Question: Briefly state, in one sentence, what is plotted here.
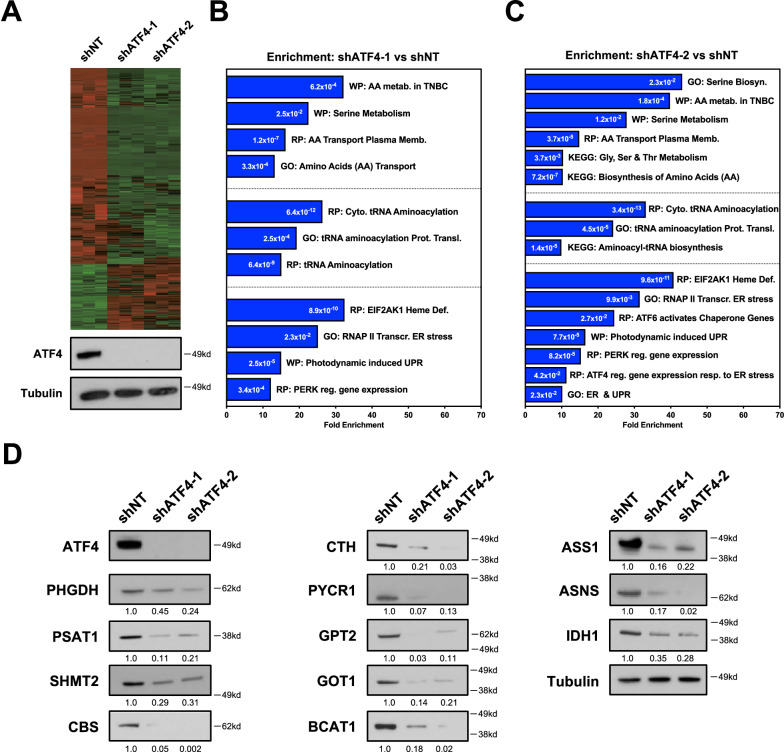
Answer: ATF4 regulates transcriptional programs associated with amino acid synthesis, import, and tRNA aminoacylation. A Top , Heatmap of differentially expressed genes between NT- and ATF4-shRNA-expressing NOMO-1 cells. Bottom , Western blot analysis of FACS-purified NOMO-1-RFP+ cells expressing DOX-inducible shNT, shATF4-1, or shATF4-2 was conducted for each replicate. RNA-seq data represent 3 replicates of the only biological replicate. B , C Pathway enrichment analysis comparing RNA-seq profiles of shNT vs shATF4-1 ( B ) or shNT vs shATF4-2 ( C ). The analysis was performed using GO_BP (GO), KEGG, Reactome (RP), and Wiki Pathways (WP). Benjamini scores are shown in white within each bar graph. D Following 48 h of DOX-treatment, NOMO-1 cells from each shRNA condition were subjected to western blot with the indicated antibodies. Quantified protein levels were normalized to tubulin. Images represent one replicate of three independent, biological replicates. Source data for all panels are provided in the Source Data file.